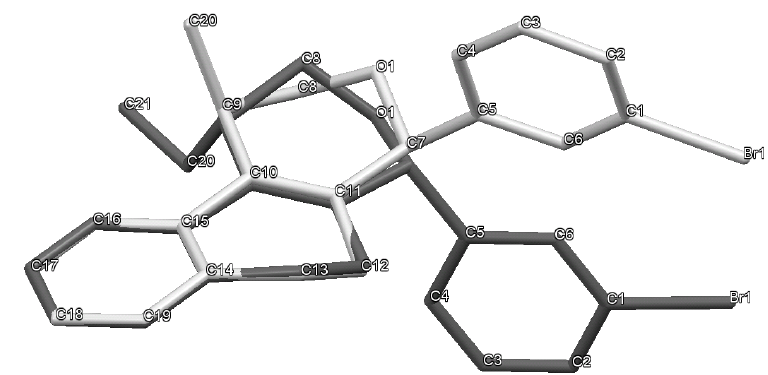
Figure 4. MERCURY view showing the superposition of opposite conformers of 7k (light gray) and 15e (dark gray). The hydrogen atoms were hidden for the representation